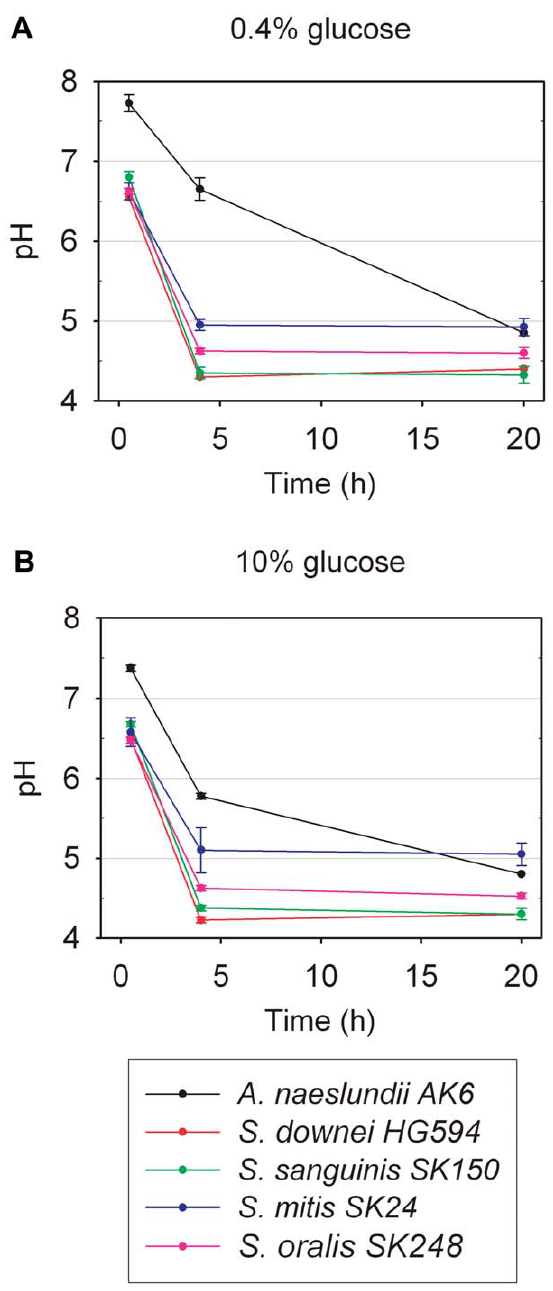
Figure 4. pH in planktonic suspension. A. Overnight cultures of S. oralis SK248, A. naeslundii AK6, S. mitis SK24, S. downei HG594, and S. sanguinis SK150 were washed twice and suspended in sterile saliva containing 0.4% (w/v) glucose. pH was measured after 30 min, 4 h and 20 h. All Streptococcus spp. reached terminal pH within four hours. pH drops in suspensions of A. naeslundii occurred more slowly. B. When glucose concentration was raised to 10% (w/v), no differences in terminal pH were observed. After 20 h, pH was lowest for S. sanguinis and S. downei (4.3–4.4) and highest for S. mitis SK24 (4.9–5). In suspensions of A. naeslundii , pH dropped more quickly as compared to 0.4% glucose. Experiments were performed in duplicate and repeated on another day. Error bars indicate standard deviations.